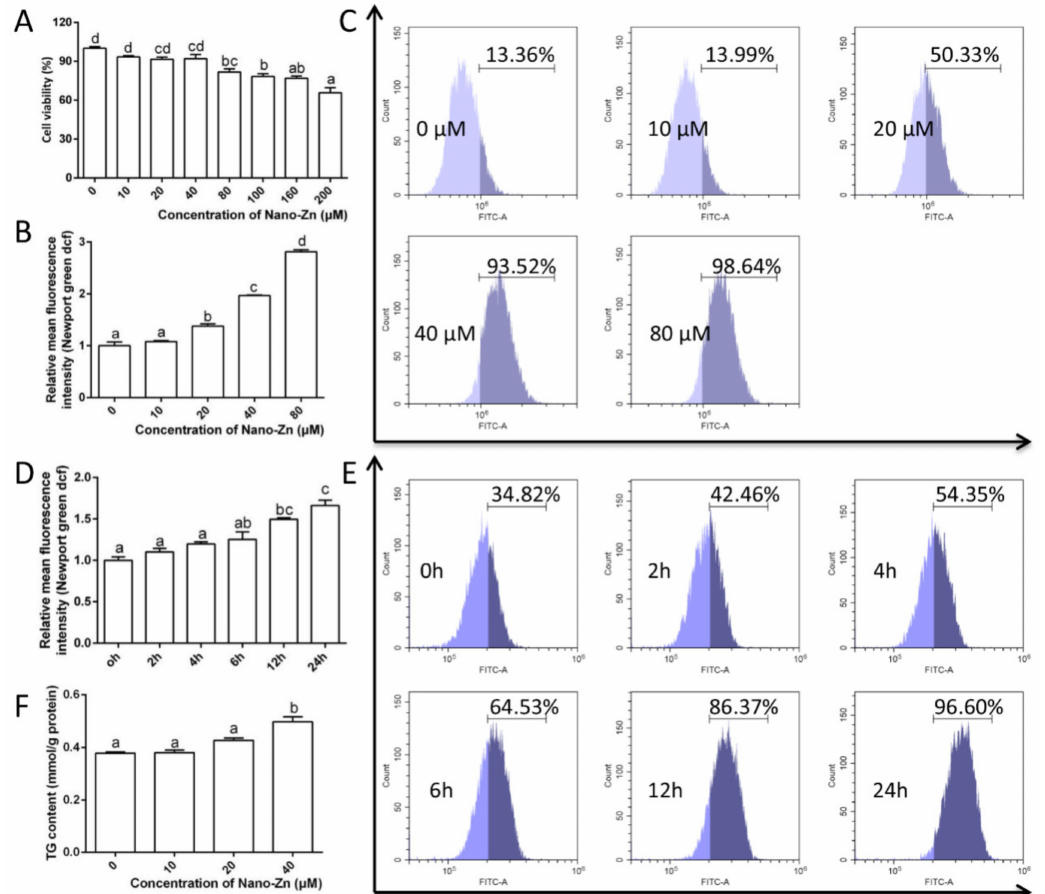
Figure 2. Nano-Zn enhanced the content of free Zn 2 + and TG accumulation in the intestinal epithelial cells of yellow catfish. ( A ) Cell viability after 24 h of nano-Zn incubation. ( B ) The free Zn 2 + quantified by calculating FL1 (green) mean fluorescence intensity (Newport Green DCF) after the primary intestinal epithelial cells were incubated with nano-Zn for 24 h. ( C ) The presence of Newport Green DCF-stained Zn 2 + demonstrated by flow cytometry analysis of green (FL1) fluorescence intensity after the primary intestinal epithelial cells were incubated with nano-Zn for 24 h. ( D ) The free Zn 2 + was quantified by calculating the FL1 (green) mean fluorescence intensity (Newport Green DCF) after the primary intestinal epithelial cells were incubated with 40 µ M nano-Zn. ( E ) The presence of Newport Green DCF-stained Zn 2 + was demonstrated by flow cytometry analysis of green (FL1) fluorescence intensity after the primary intestinal epithelial cells were treated with 40 µ M nano-Zn. ( F ) TG content after 24 h of nano-Zn incubation. Values indicate means ± SEMs, n = 3–6. Di ff erent letters indicate significant di ff erences among groups at p <